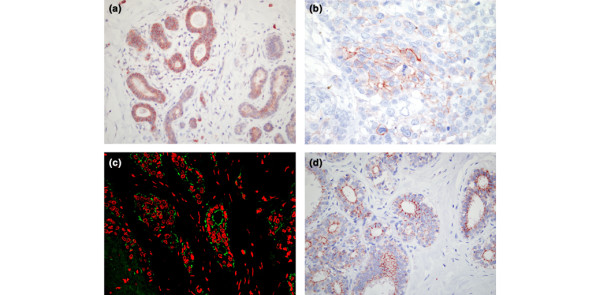
Claudin (CLDN)3 positivity in benign breast tissue and invasive ductal breast carcinoma. (a) CLDN3 positivity in benign breast tissue. Regular immunohistochemical reaction of benign breast epithelial cells using polyclonal CLDN3 antibody. Continous membrane staining characterizes most of the luminal epithelial cells. Sections were counter-stained with Mayer's haemalaun. The chromogen substrate was aminoethylcarbazol. (Original magnification: 400×.) (b) CLDN3 positivity in invasive ductal breast carcinoma. CLDN3 positivity is apparent in the membranes of some carcinoma cells. Sections were counter-stained with Mayer's hemalaun. The chromogen substrate was aminoethylcarbazol. (Original magnification: 600×.) (c) CLDN3 positivity in benign breast epithelium. CLDN3 positivity is seen in the majority of the membranes of benign epithelial cells. CLDN3 appeared to be localized in normal breast close to the apical end of the cell membranes or in the basolateral membranes of the epithelial cells. The primary antibody was CLDN3 polyclonal antibody (Zymed); the secondary antibody was IgG conjugated to Alexafluor 488 (Molecular Probes). Cell nuclei were counter-stained with propidium iodide. The image was obtained using laser scanning confocal microscopy (MRC 1024; Bio-Rad). (Original magnification: 400×.) (d) CLDN3 positivity in benign breast epithelium. CLDN3 positivity is seen in the membranes of the majority of breast epithelial cells. The positive membrane reaction is incomplete in most of the cells. The primary antibody was CLDN3 polyclonal antibody (Zymed). Sections were counter-stained with Mayer's haemalaun. The chromogen substrate was aminoethylcarbazol. (Original magnification: 400×.)